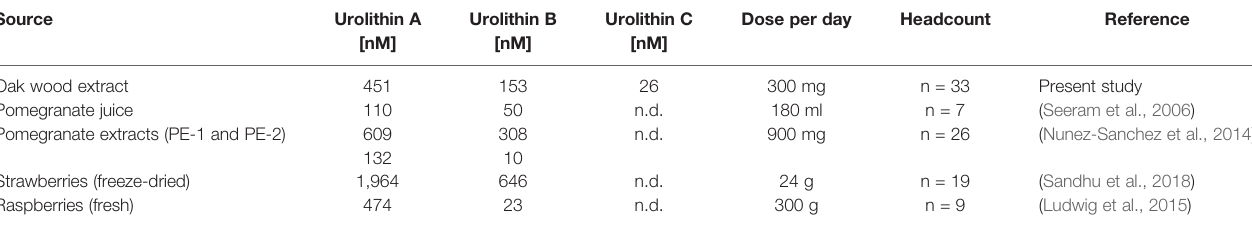
TABLE 4 | Comparison of mean urolithin concentrations determined in serum/plasma samples of humans after ingestion of different sources of ellagitannins.